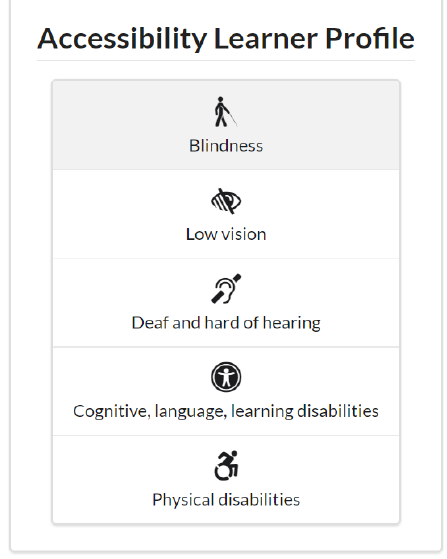
Figure 3. GUI to select and configure the accessibility learner profile.